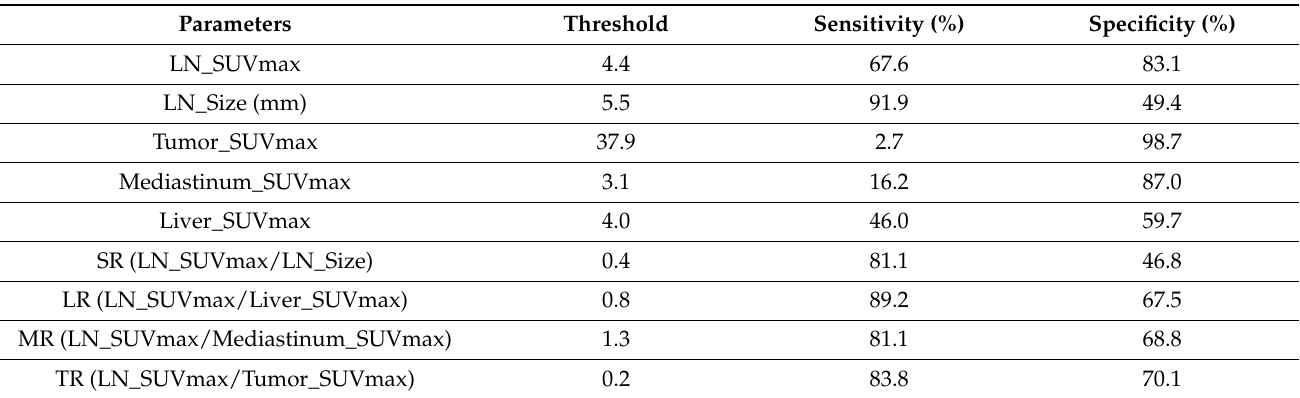
Table 5. Pairwise comparison of sensitivity and specificity in predicting N2 nodal involve- ment based on selected thresholds for each parameter (see Table 4) using the McNemar